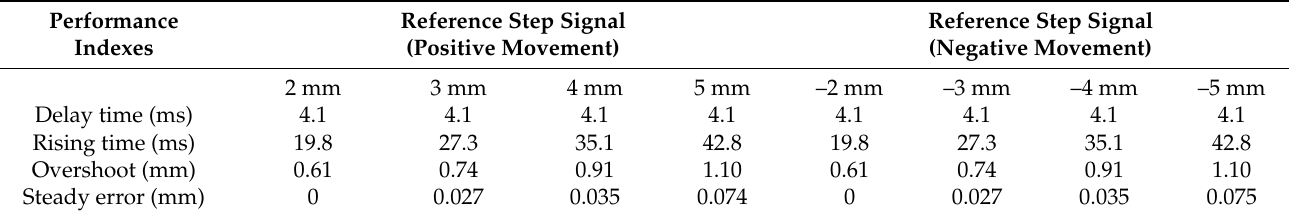
Table 3. Performance indexes for step